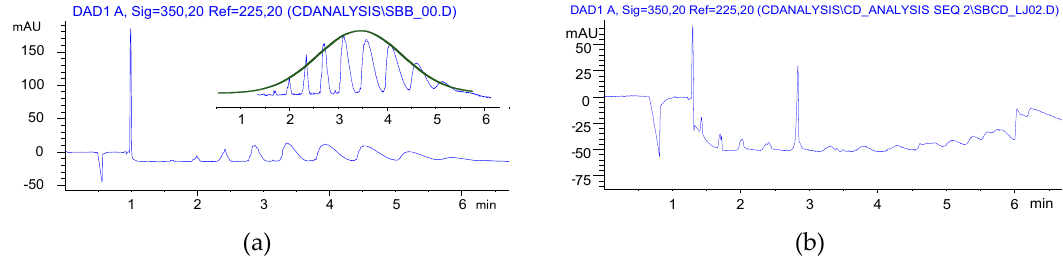
Figure 4. Capillary electropherograms of sulfobutylated β CD ( a ) synthesized in solution (compound 4 , item 7 in Table 1); ( b ) synthesized in ball mill (compound 4 ′ , item 13 in Table 1).